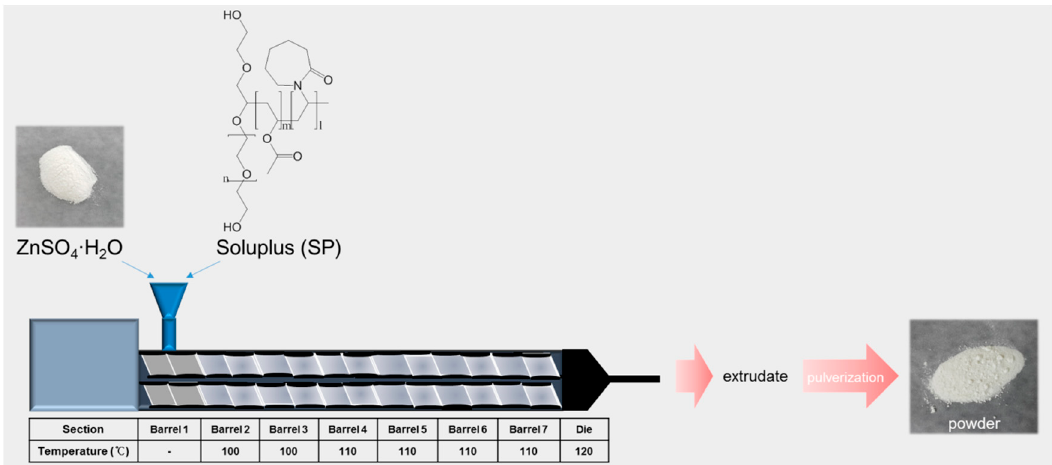
Figure 1. Schematic illustration of the HME process for the development of ZnSO 4 /SP NC formulation.